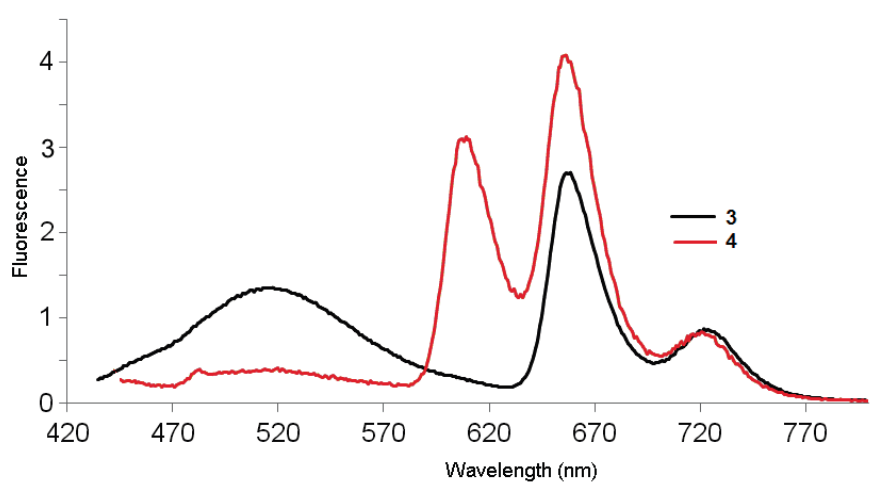
Figure 4. Fluorescence spectra of dendrimers 3 and 4 in CH 2 Cl 2 at room temperature at the concentration of 3.0 × 10 − 6 M ( λ ext. 420